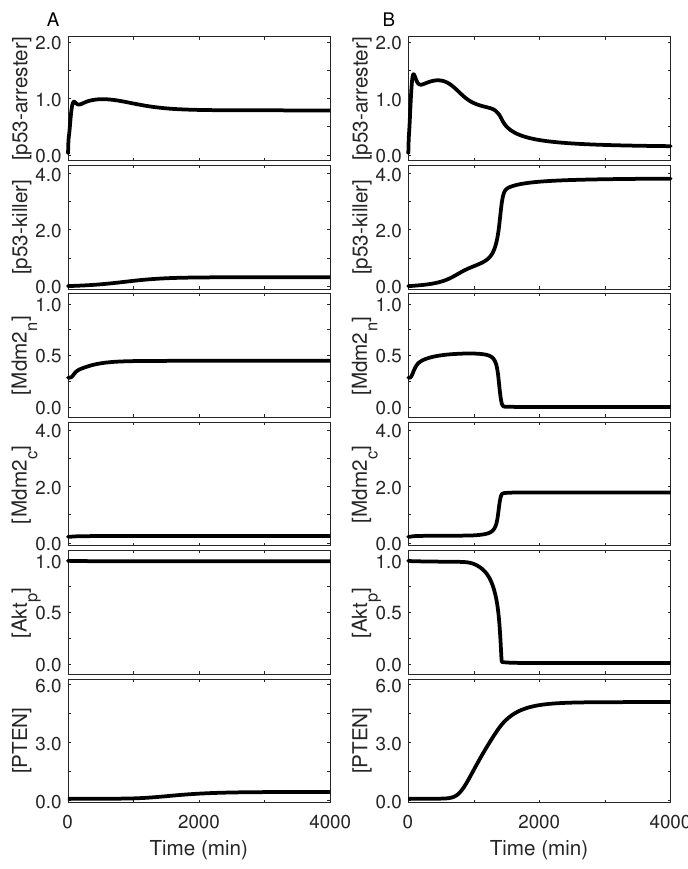
Figure 5. p53 dynamics and the associated feedback control. Shown is temporal evolution of the levels of p53-arrester, p53-killer, nuclear Mdm2, cytoplasmic dephosphorylated Mdm2, Akt p , and PTEN (from top to bottom) at C g = 0.2 mM ( A ) or 0.08 mM ( B